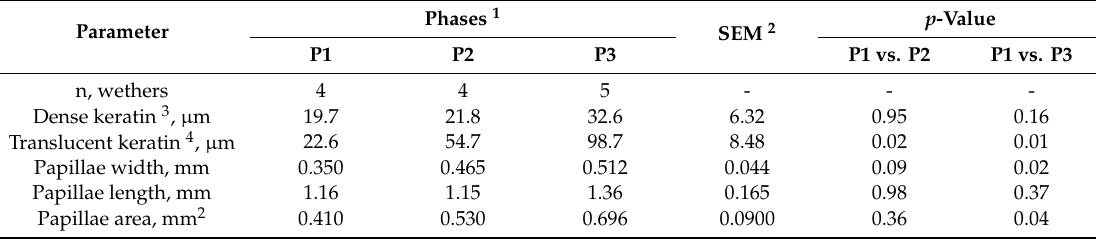
Table 4. Impacts of time-fed concentrate-based diets on rumen histology of